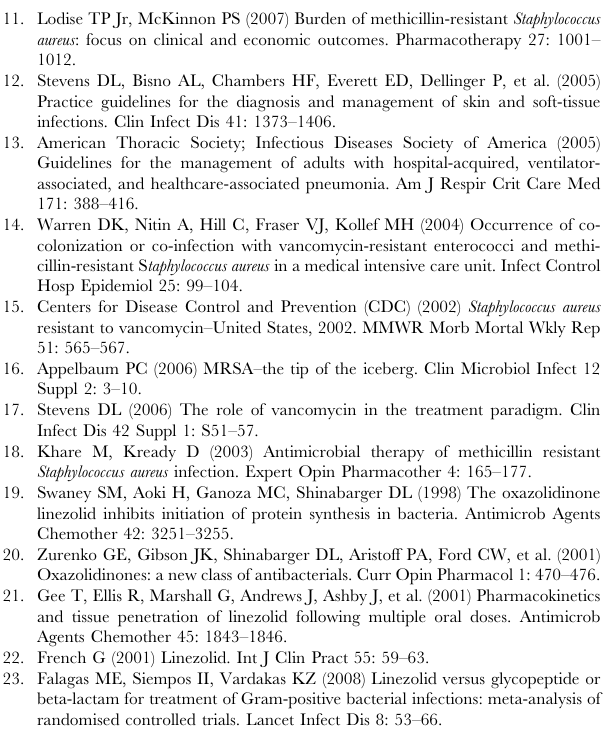
Figure S1 Begg’s funnel plot with 95% confidence limits to detect publication bias. Each point represents a separate study for the indicated